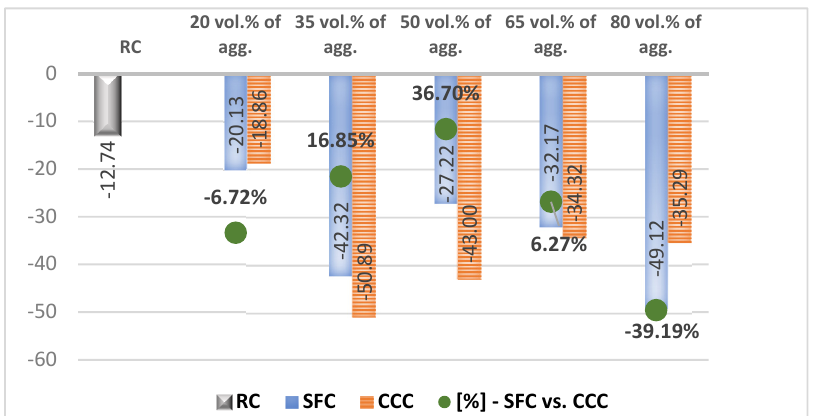
Figure 11. Loss in compressive strength of concrete with aggregates from sunflower stalks versus that with aggregates from corn cobs, following freeze-thaw testing [%].